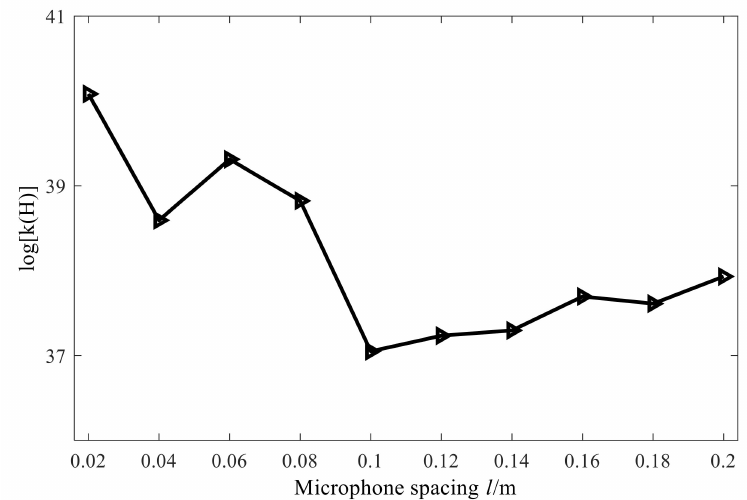
Figure 15. Influence of microphone spacing on conditional